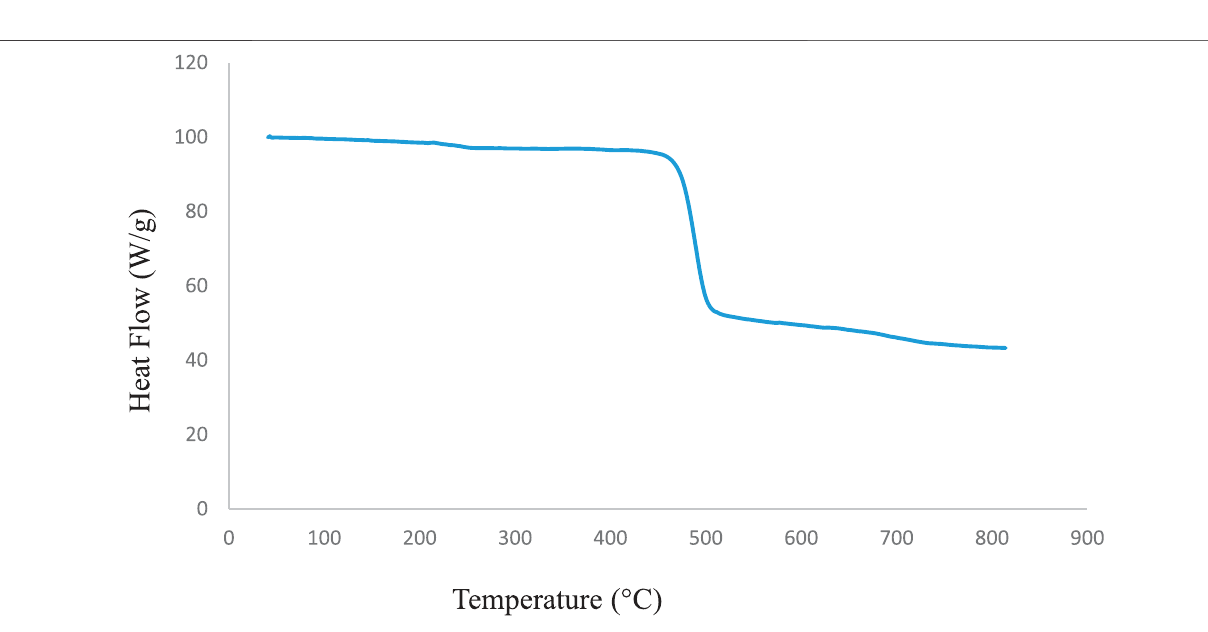
Frontiers in Chemistry |